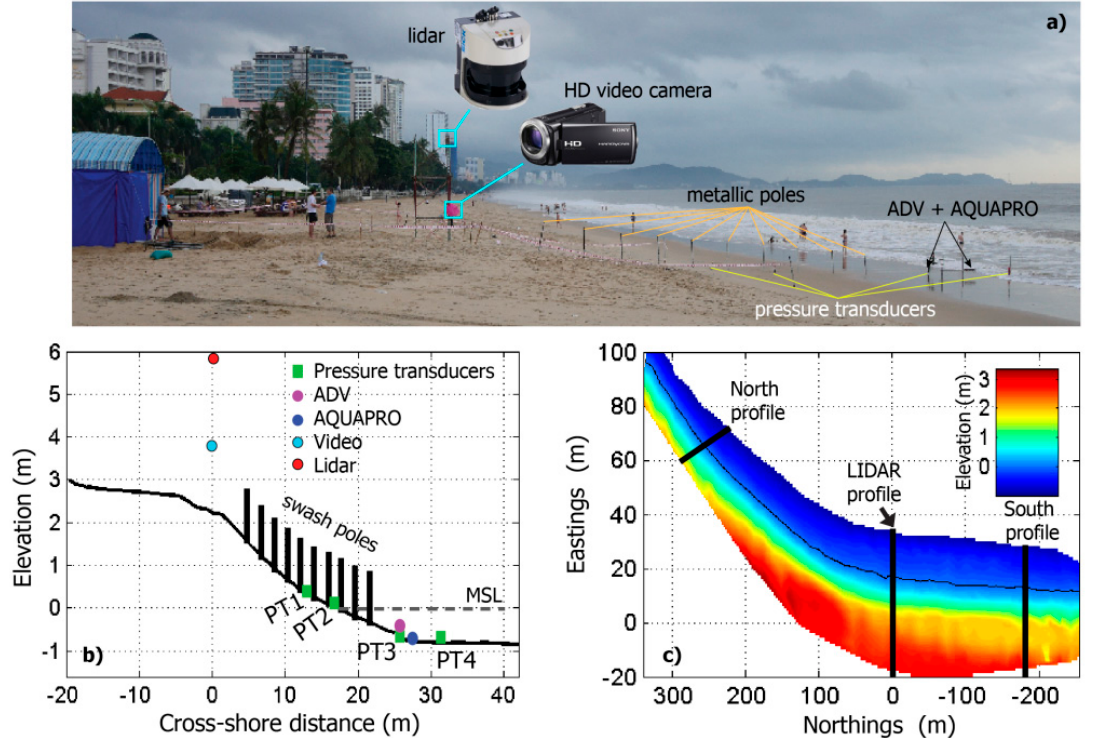
Figure 2. Photograph showing the arrangement of all instruments along a cross-section of the beach ( a ); beach profile with instrument location and mean sea level (MSL) indication during this experiment ( b ); contour map of the study site topography with LIDAR profile location and two additional profiles used in this analysis ( c ).